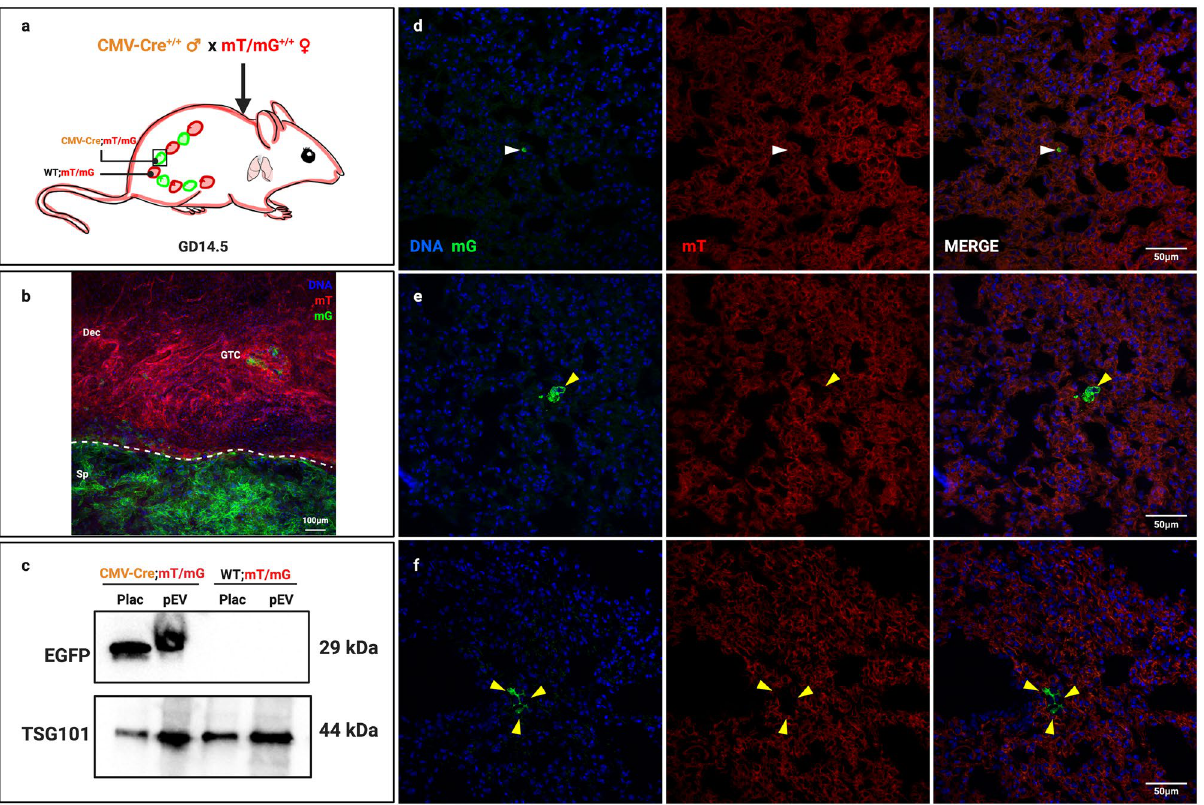
Figure 6. In Vivo Localization of mGFP in CMV-Cre Mated Maternal mT/mG Lung. ( a ) mT/mG females mated to a CMV-Cre males give rise to female pups ubiquitously expressing mGFP and male pups expressing mTomato. ( b ) GD14.5 utero-placental interface of a female fetus from a mT/mG x CMV-Cre mating. Fetal mGFP-expressing placental cells (Sp; spongiotrophoblast) are readily distinguishable from maternal mTomato- expressing decidual cells (Dec); invading glycogen trophoblast (GTC) can also be seen. The dashed line demarcates the fetomaternal interface. Representative image of three independent experiments using 5 total animals (n = 5). ( c ) Western blot of GD14.5 placenta (Plac) and placental EVs (pEVs) from mT/mG females mated with CMV-Cre or WT males; image is representative of four biological replicates. ( d ) Representative confocal image (of 5 random fields) of punctate mGFP-positive foci localization in maternal mT/mG GD14.5 lung after mating to a CMV-Cre male. N = 5. ( e , f ) Confocal localization of mG+ recombined cells in maternal mT/mG GD14.5 lung after mating to a CMV-Cre male. Images are representative of five biological replicates. White arrows; punctate mGFP-positive foci. Yellow arrows; mGFP-positive, recombined